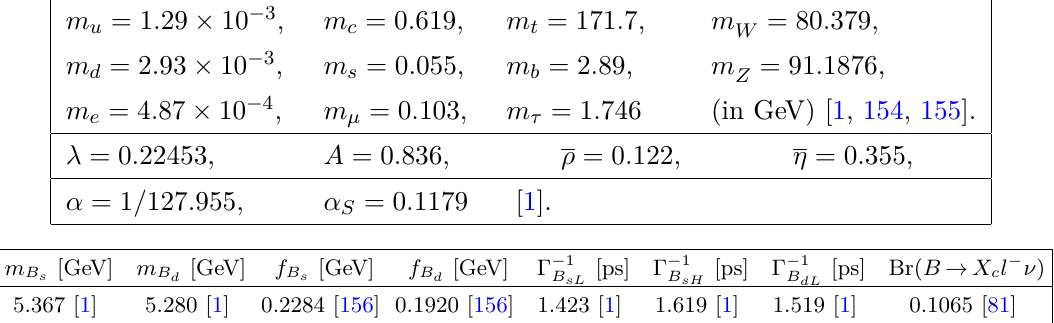
Table 2 . The input parameters of the SM. The masses of the SM fermions and gauge bosons shown in the above table are the values at the Z boson scale, and they are given in GeV. The symbols λ , A , ρ and η are the Wolfenstein parameters [157]. The coupling constants α and α S are the fine structure constant of QED and QCD, respectively. The below table shows the input parameters for the analyses of the flavor